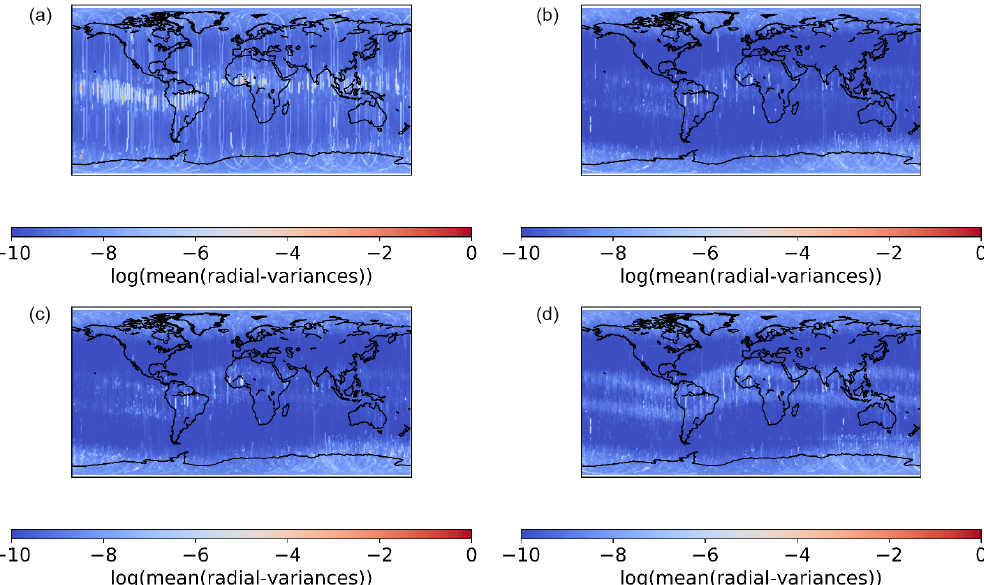
Figure 14. Radial variances for the analyzed test period, global. (a, b) AIUB standard screening (a) and AIUB-ROTI (b) ; (c, d) Graz- ROTI (c) and second derivative limited to the equatorial region (eq.) + AIUB-ROTI (d) . The clearly visible ground track (a) is due to a large rms for Swarm A, 29 March